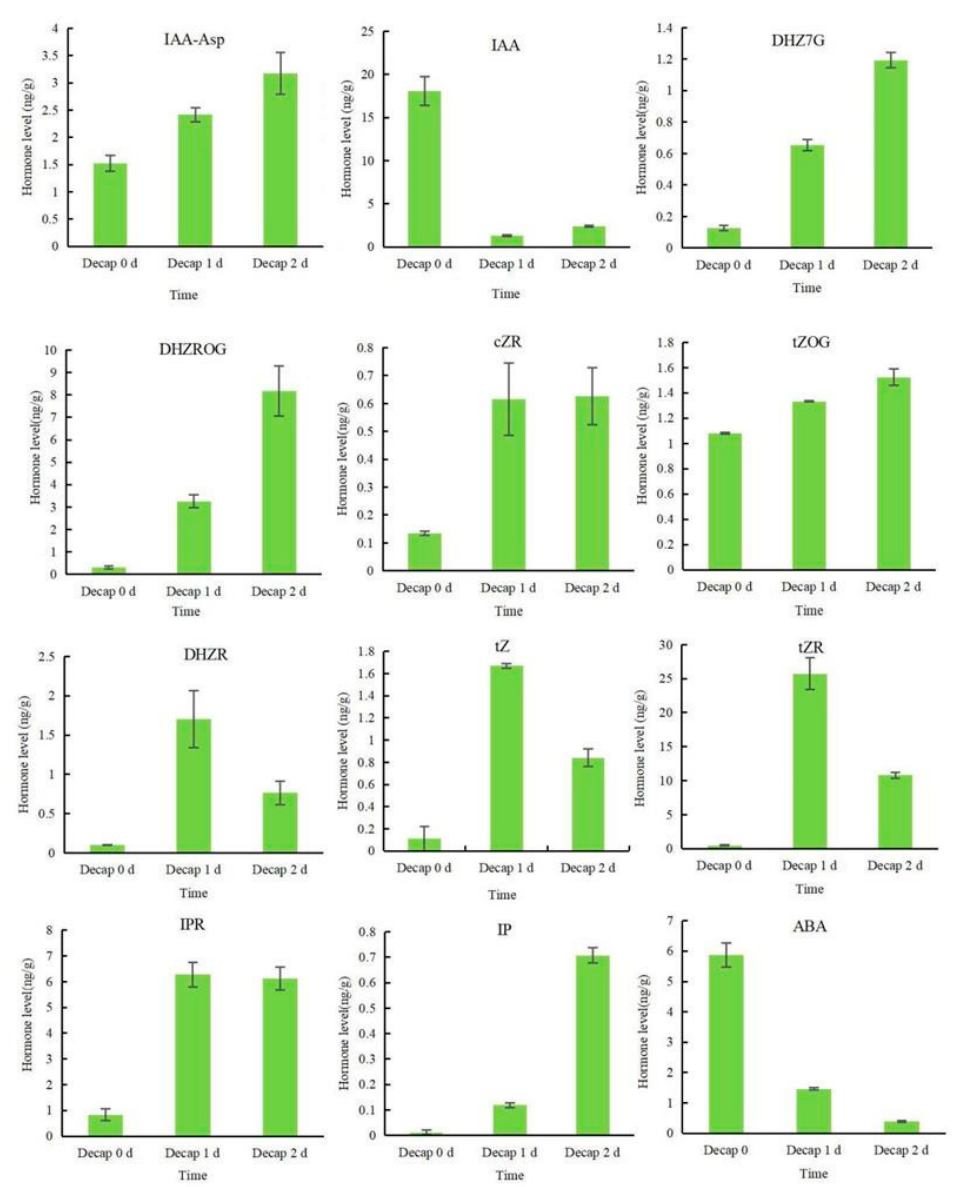
Figure 2. Effects of decapitation on the hormone levels of sunflower flower buds. Data indicate the means ± SE ( n = 20 plants).